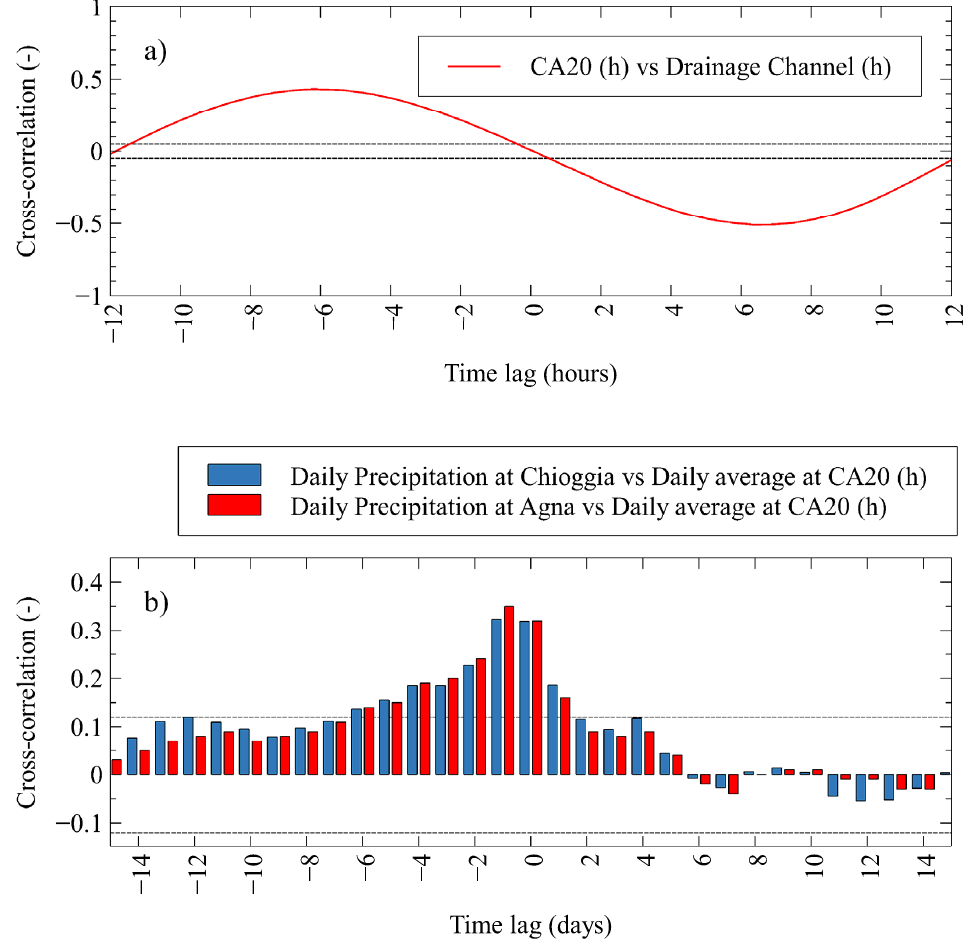
Figure 13. ( a ) DC level and CA20 h cross-correlation over the time span 16th July–1st August (2303 values); ( b ) Cross-correlation functions between daily precipitation in the close neighbors (SA and AG) and CA20 water level over the period 31 January 2020 to 10 November